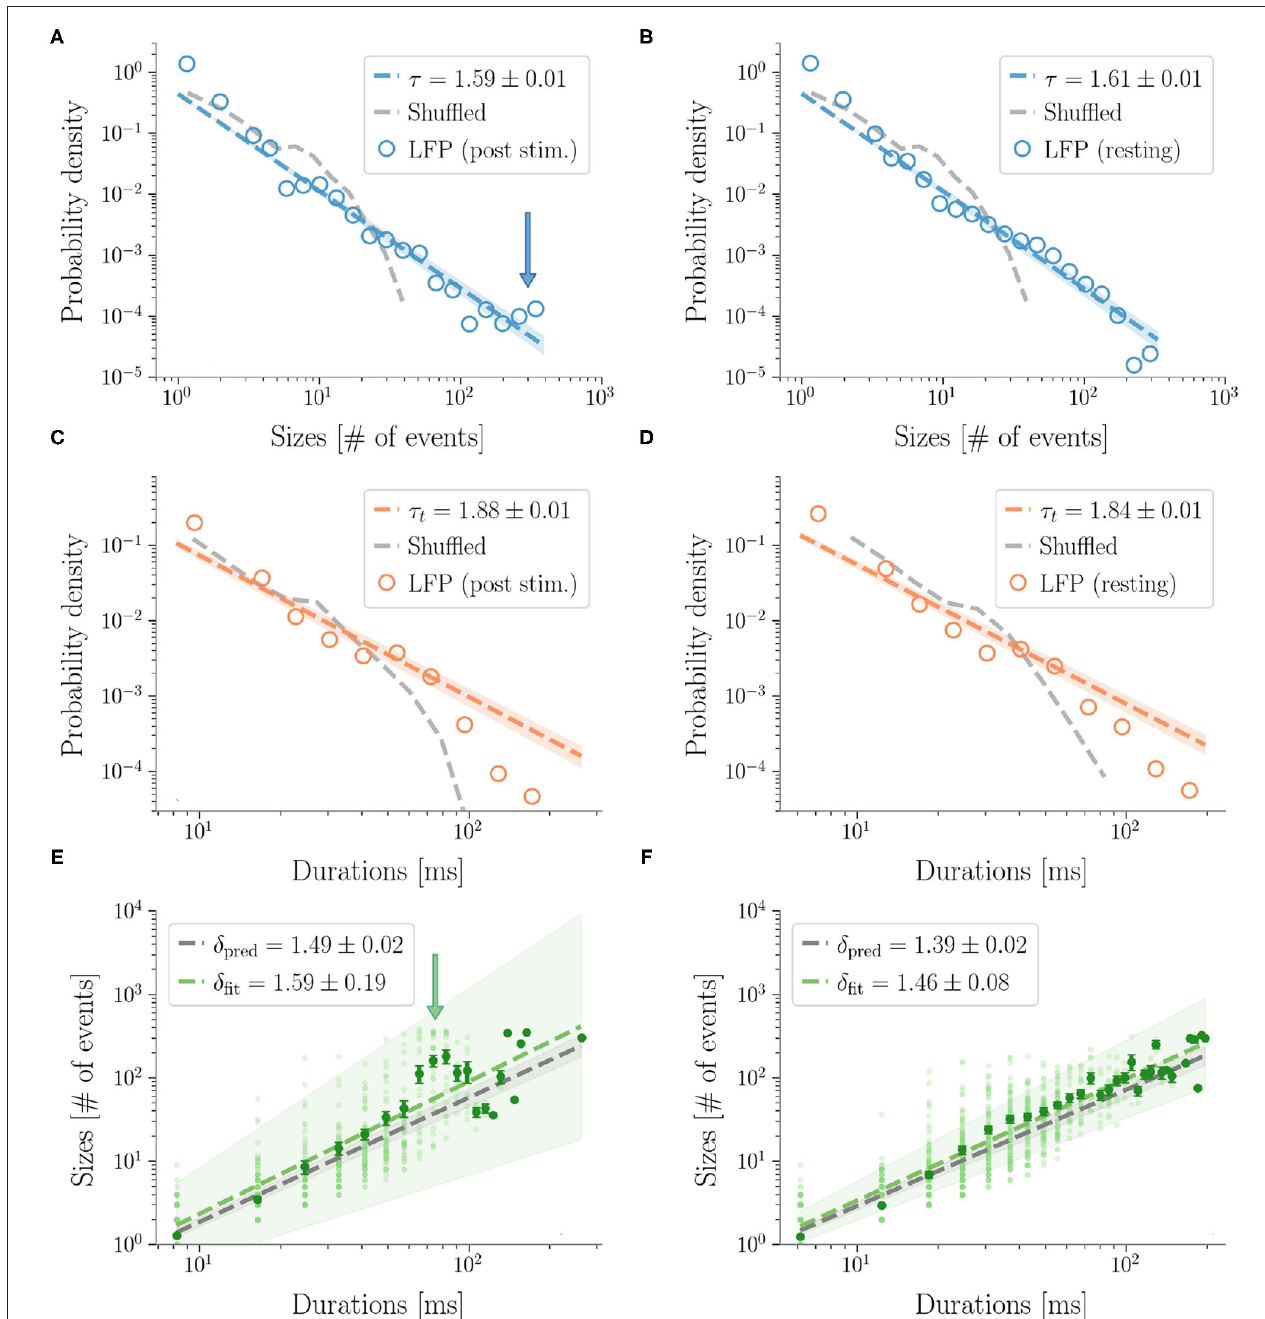
FIGURE 4 | LFP avalanches. Representative probability densities of avalanches sizes in one rat after the sensory stimulus (A) , or in resting state conditions (B) . A bump deviating from the power law can be recognized in the post-stimulus distribution in correspondence of large avalanche sizes, pointed to by an arrow. Distributions of the avalanches’ durations do not display clear alterations instead (C,D) . Durations are expressed in ms by multiplying the number of bins by h IEI i . In the randomized dataset the exponential distribution provides a better fit in all cases (dashed gray lines). The shuffling procedure consists in randomizing the occurrence times of the events of each channel, so that the events rate of each channel is preserved. (E,F) The crackling noise relation is verified in both cases within the experimental errors (i.e., δ pred is compatible with δ fit ). Once more, notice in (E) the presence of a bump (indicated by an arrow) in the post-stimulus regime. e.g., the primary visual cortex, where functional columns of the whiskers in this primary sensory cortex, where single whiskers are mapped to single cortical columns with a one-to- one correspondence. This differentiates the barrel cortex from,